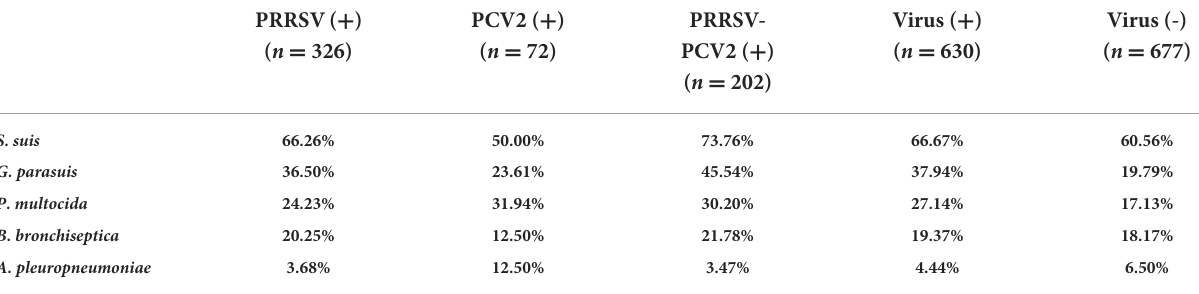
TABLE 2 Isolation rate of various bacteria under different virus infections.